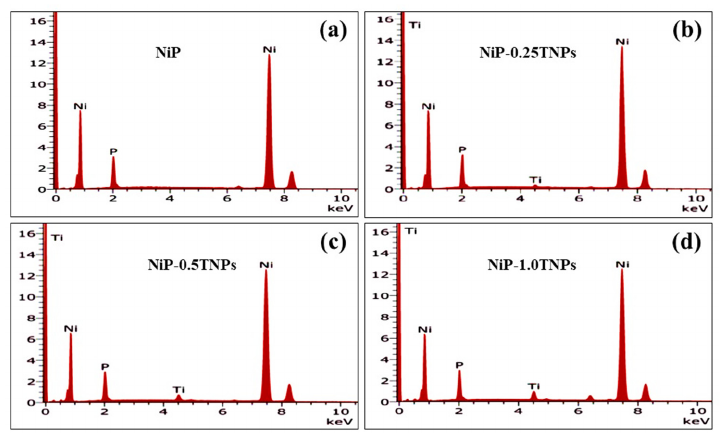
Figure 4. Energy dispersive spectroscopy (EDX) scan spectra of ( a ) NiP, ( b ) NiP-0.25TNPs, ( c ) NiP-0.5TNPs and ( d ) NiP-1.0TNPs nanocomposite coatings. Table 3. Elemental compositions of the di ff erent obtained coatings.